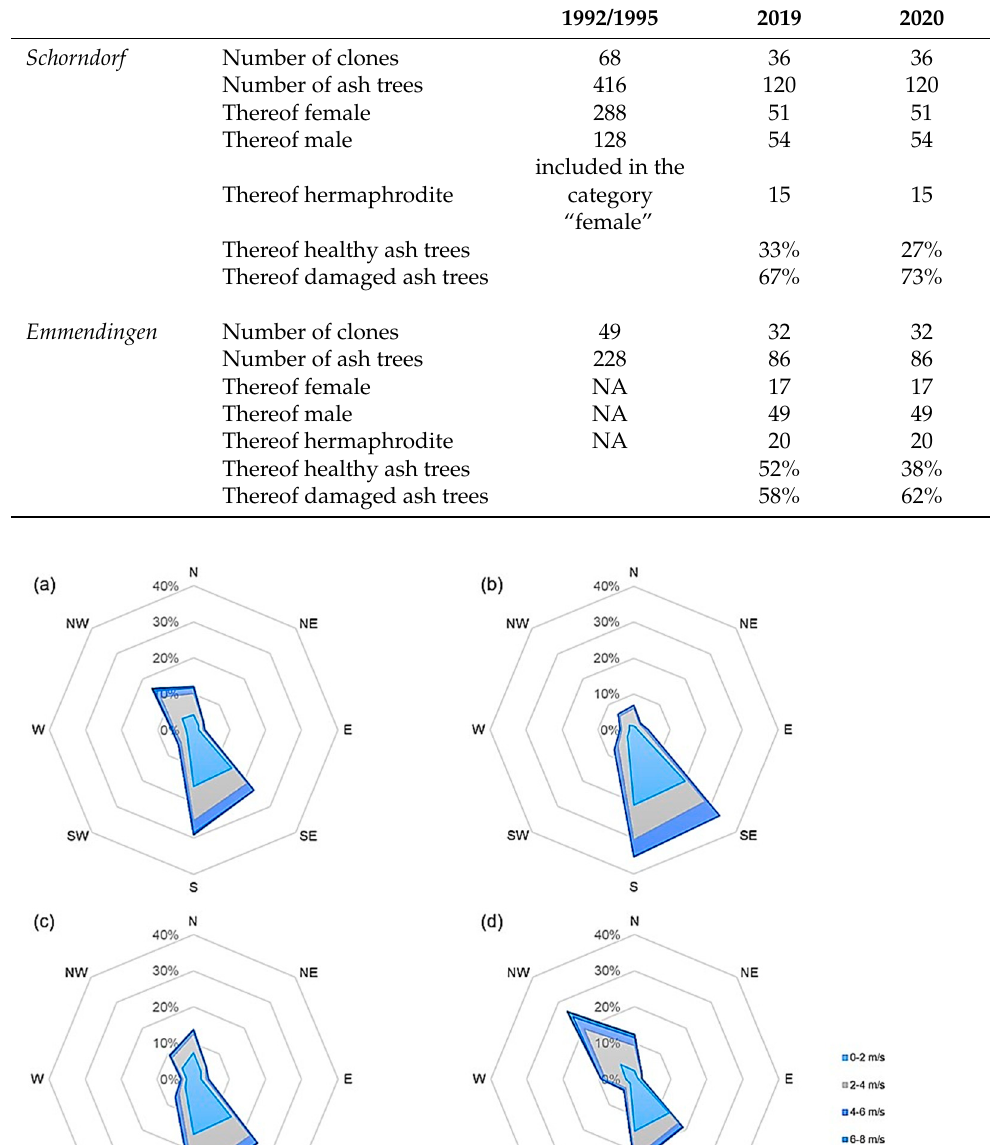
Table A1. Plantation tree information.